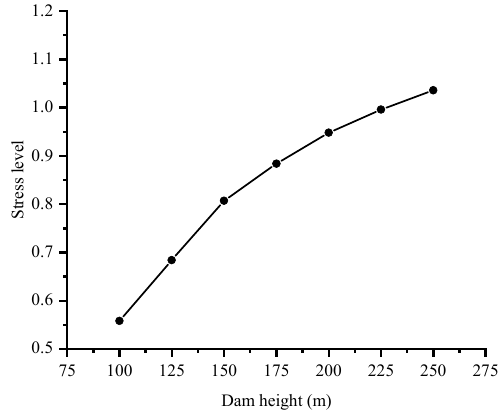
Figure 9. Relationship between stress level maximum of ACC and dam height.